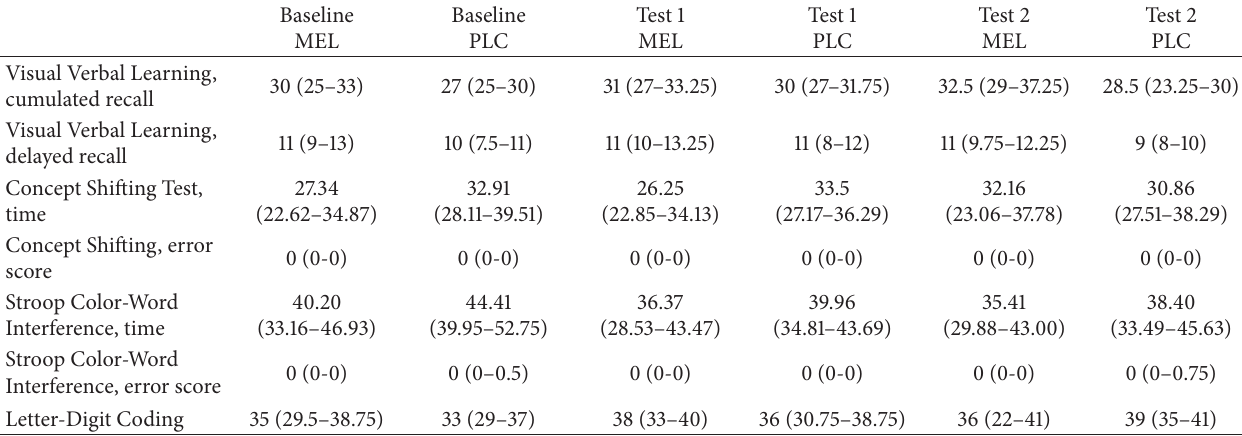
Table 3: The 7 variables of the 4 neuropsychological